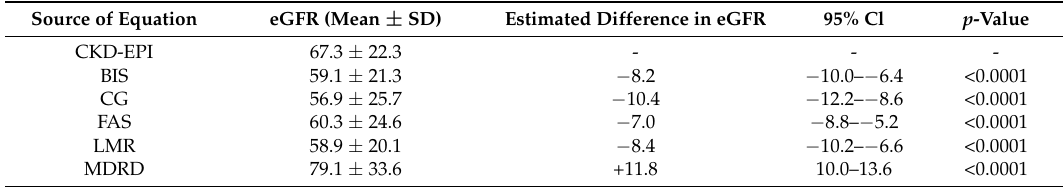
Table 2. Estimated eGFR (mL/min/1.73 m 2 ) and mean difference in eGFR values between the CKD-EPI standard equation and the five alternative eGFR equations (n = 118). p -values illustrate differences compared with the CKD-EPI